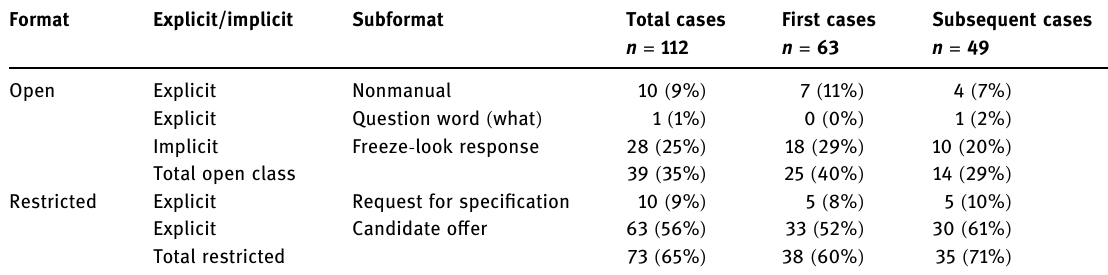
Table 2: Distribution of di ff erent formats for repair initiation in the total NTS data and in fi rst and subsequent cases